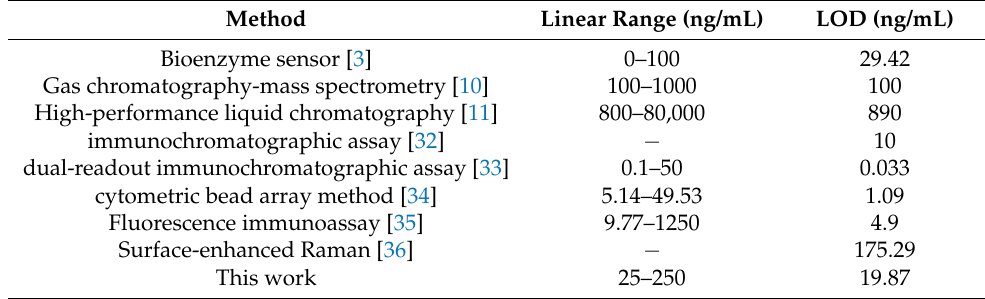
Table 1. A comparison of the different methods for the detection of chlorpyrifos.